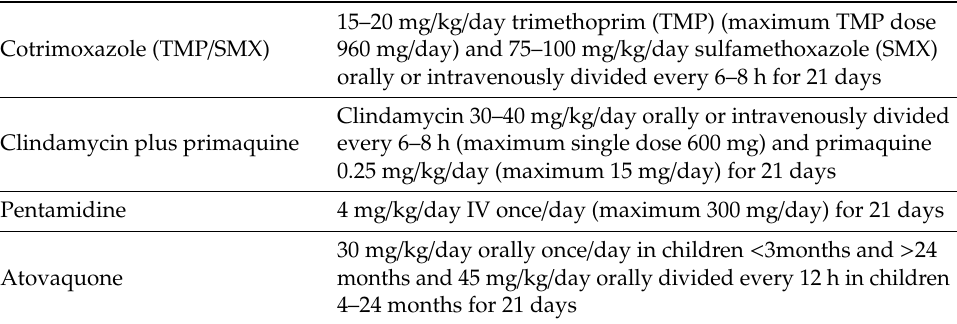
Table 4. Therapeutic regimens for PJP in children with leukemia and HSCT